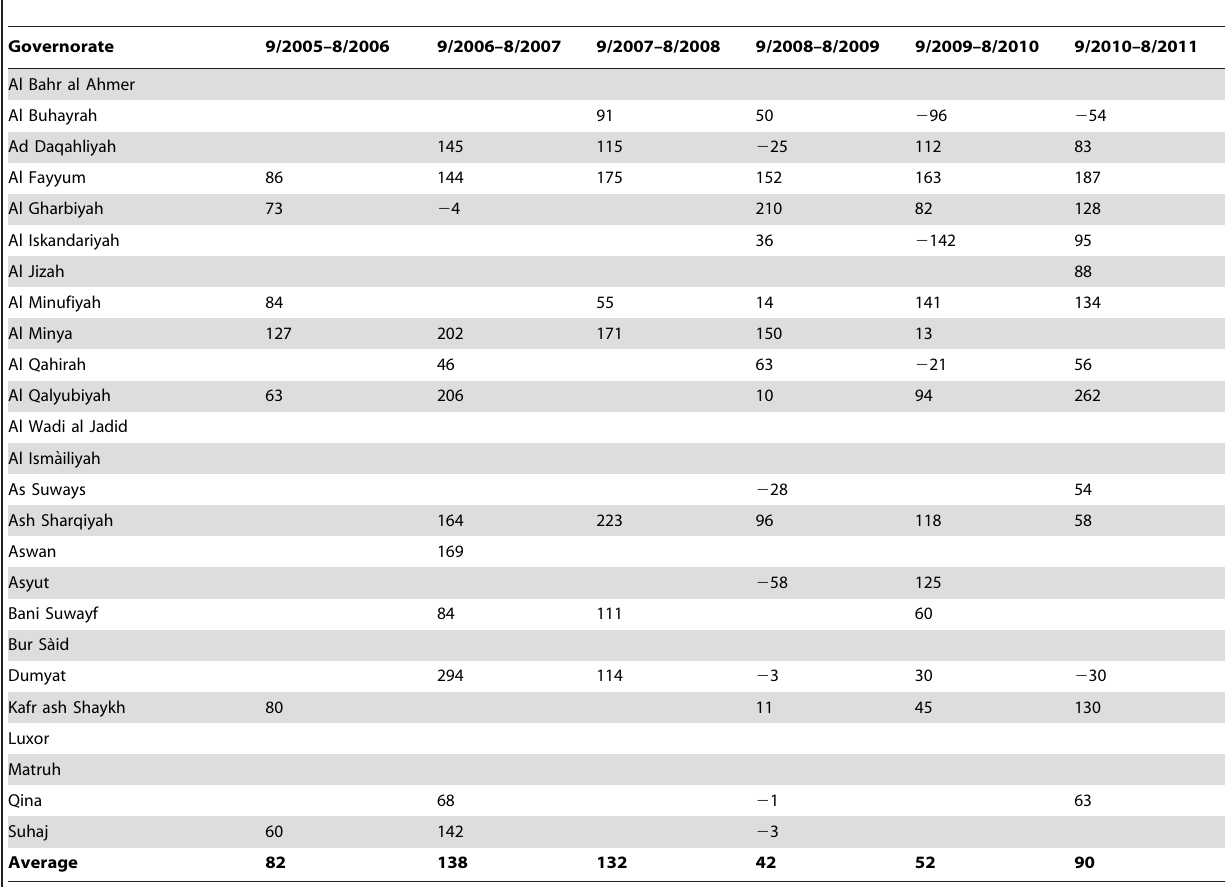
Table 1. Number of days between first bird outbreak and human case for each season (9/1–8/31).